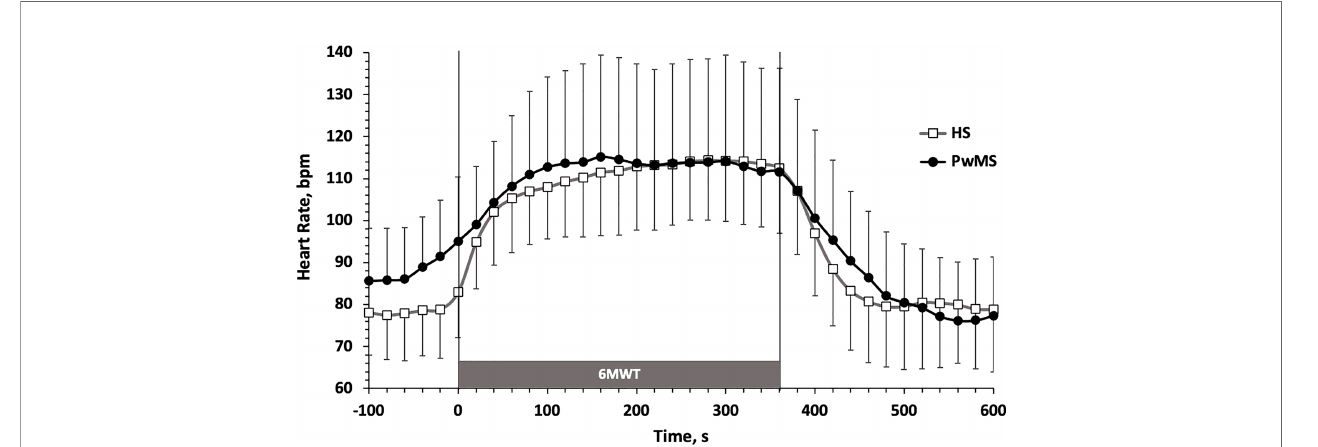
FIGURE 2 | Heart Rate (m±SD) time course before, during and after the 6MWT. HS, Healthy Subjects; PwMS, Persons with Multiple Sclerosis. Black line and close circles: PwMS; grey line and open